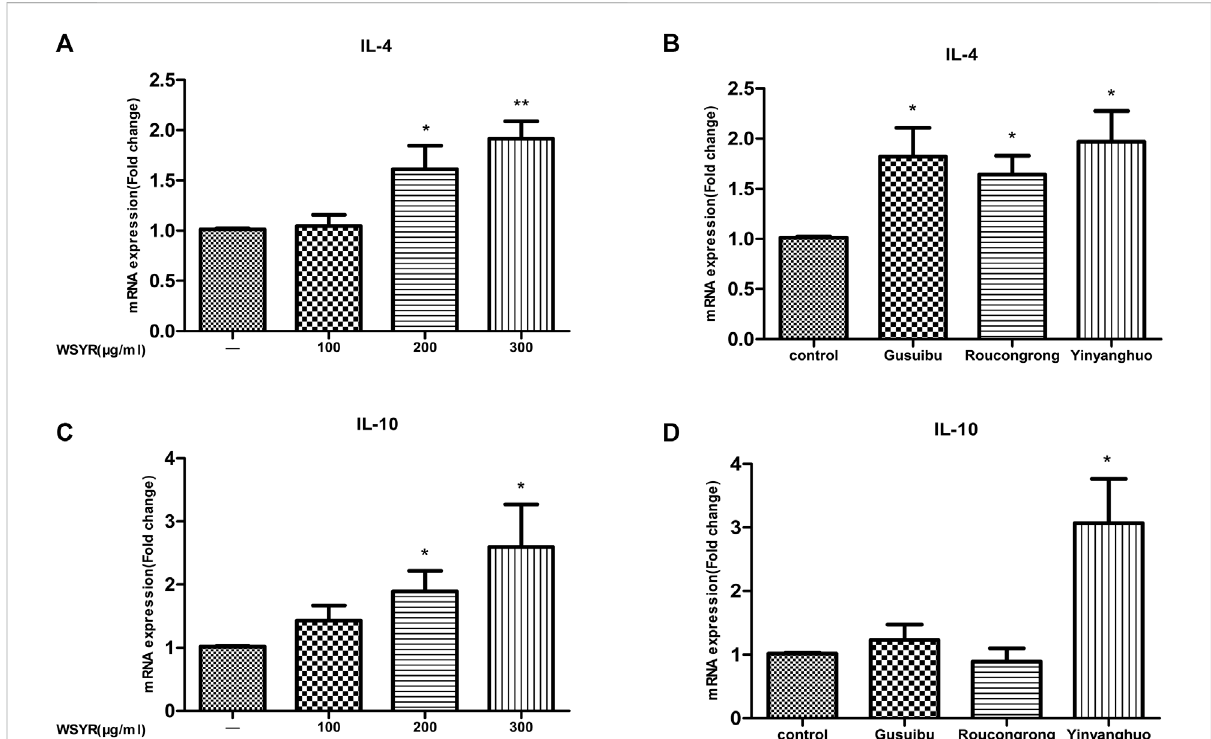
FIGURE 6 Action ofWSYRand itsherbsGusuibu, Roucongrong,YinyanghuoonSK-OV-3 cells. SK-OV-3 cellsweretreatedwith WSYR (100,200,300 μ g/ ml),Gusuibu(200 μ g/ml),Roucongrong(200 μ g/ml),Yinyanghuo(200 μ g/ml)for24 h.ThemRNAexpressionof IL-4 (A,B) , IL-10 (C,D) wasanalyzed by qPCR. * p < 0.05 and ** p < 0.01 indicate statistical signi fi cance compared to